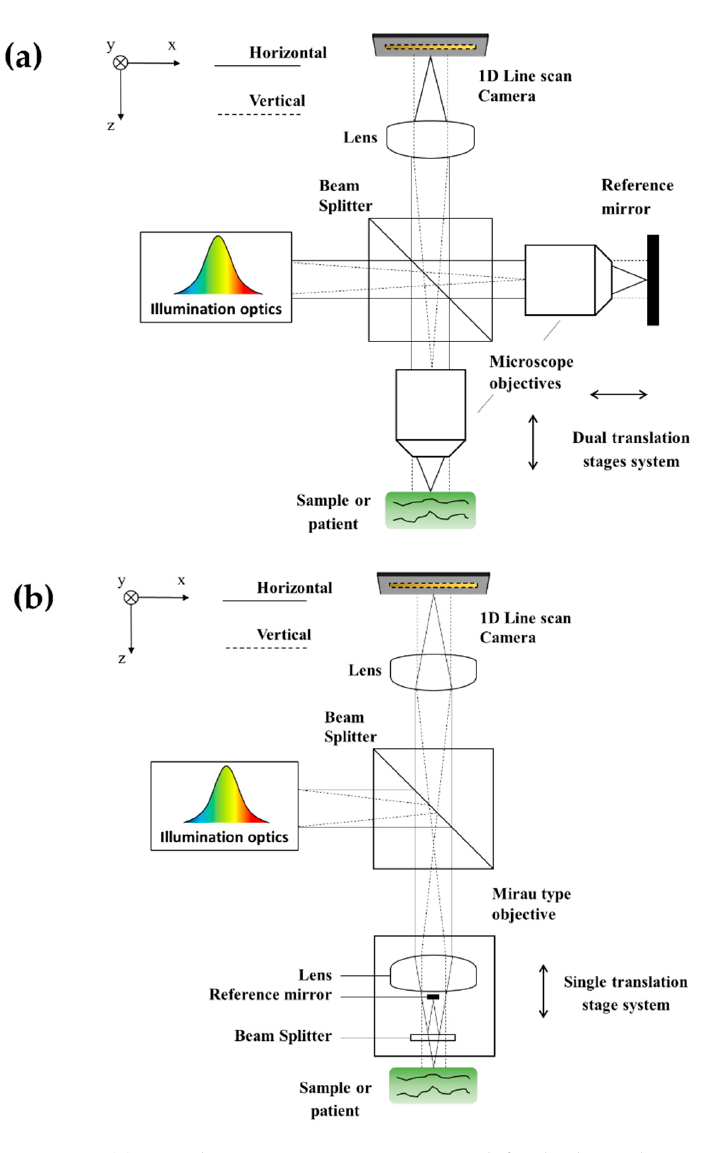
Figure 8. ( a ) Linnik LF-TD-OCT, as optimised for high-resolution confocally gated imaging. ( b ) Mirau variant, using only a single translational stage. Note that galvo mirrors (not shown) can be included in both variants to allow 3D imaging.